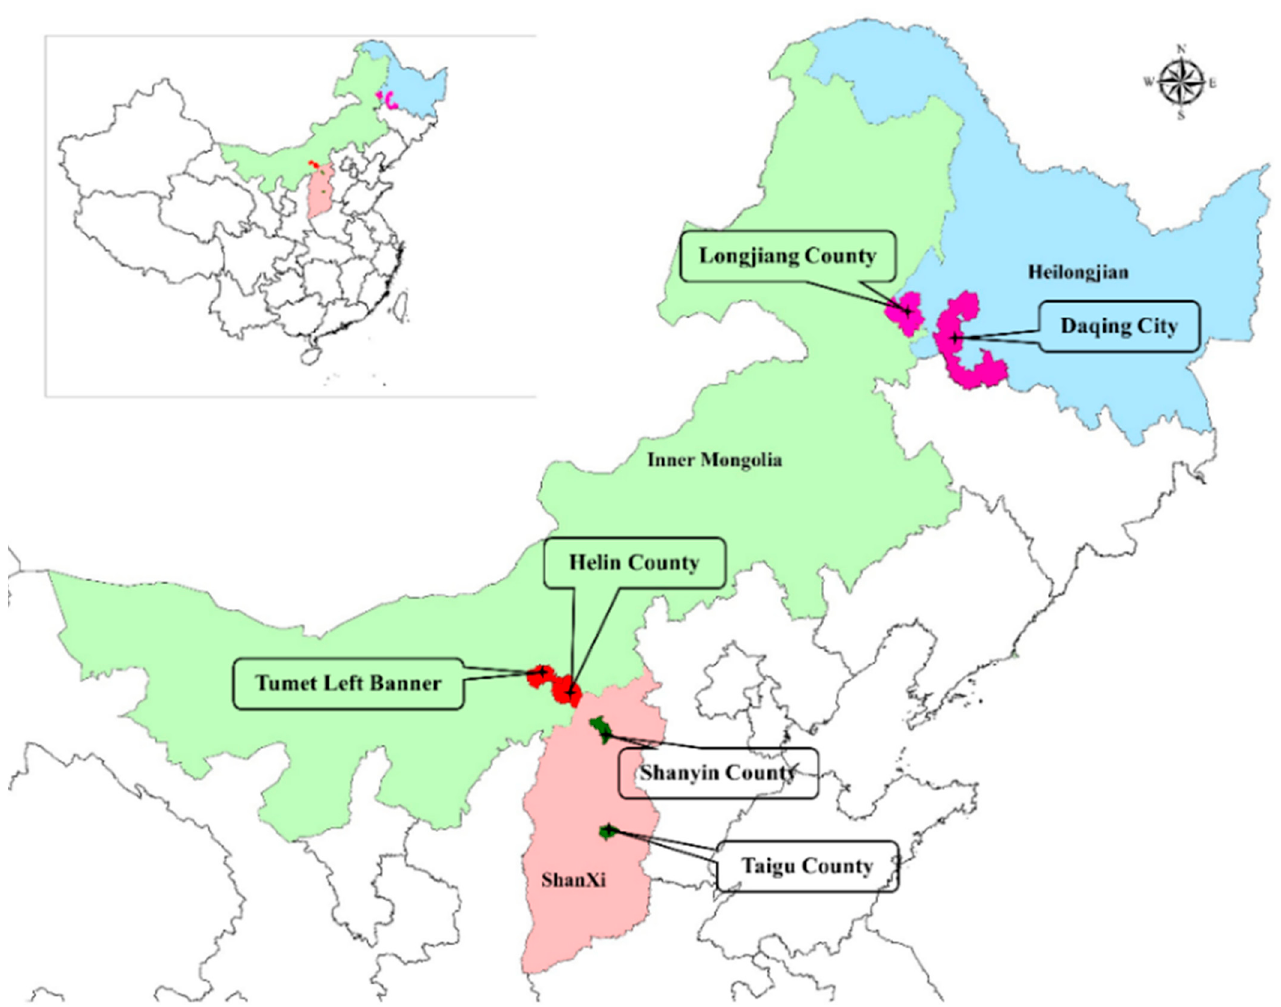
Figure 1. Sampling locations of whole-plant corn. Heilongjiang province (Daqing city (124°43 ′ 42.074 ″ E, 46°18 ′ 32.083 ″ N) and Longjiang county (123°7 ′ 32.120 ″ E, 47°21 ′ 23.396 ″ N), cold and wet agricultural area), Inner Mongolia Autonomous Region (Helin county (111°36 ′ 21.625 ″ E, 40°28 ′ 47.672 ″ N) and Tumet Left Banner (111°9 ′ 31.399 ″ E, 40°41 ′ 29.832 ″ N), tem- perate and dry pastoral area) and Shanxi province (Taigu (112°37 ′ 53.792 ″ E, 37°25 ′ 57.230 ″ N) and Shanyin (112°52 ′ 06.676 ″ E, 39°32 ′ 54.503 ″ N) counties, temperate and dry agricultural area).